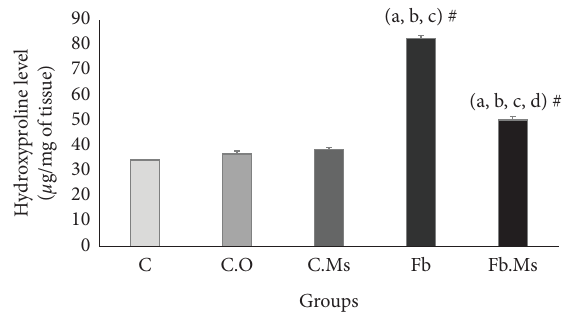
Figure 3: Hydroxyproline content in the lung tissue of the studied animals. C: control group; C.O: olive oil control group. C.Ms: hMSC-CM control group, Fb: fbrosis group, Fb.Ms: group Fb with hMSC-CM treatment. ( # p < 0 . 001). a Signifcantly diferent from C. b Signifcantly diferent from C.O. c Signifcantly diferent from C.Ms. d Signifcantly diferent from that of